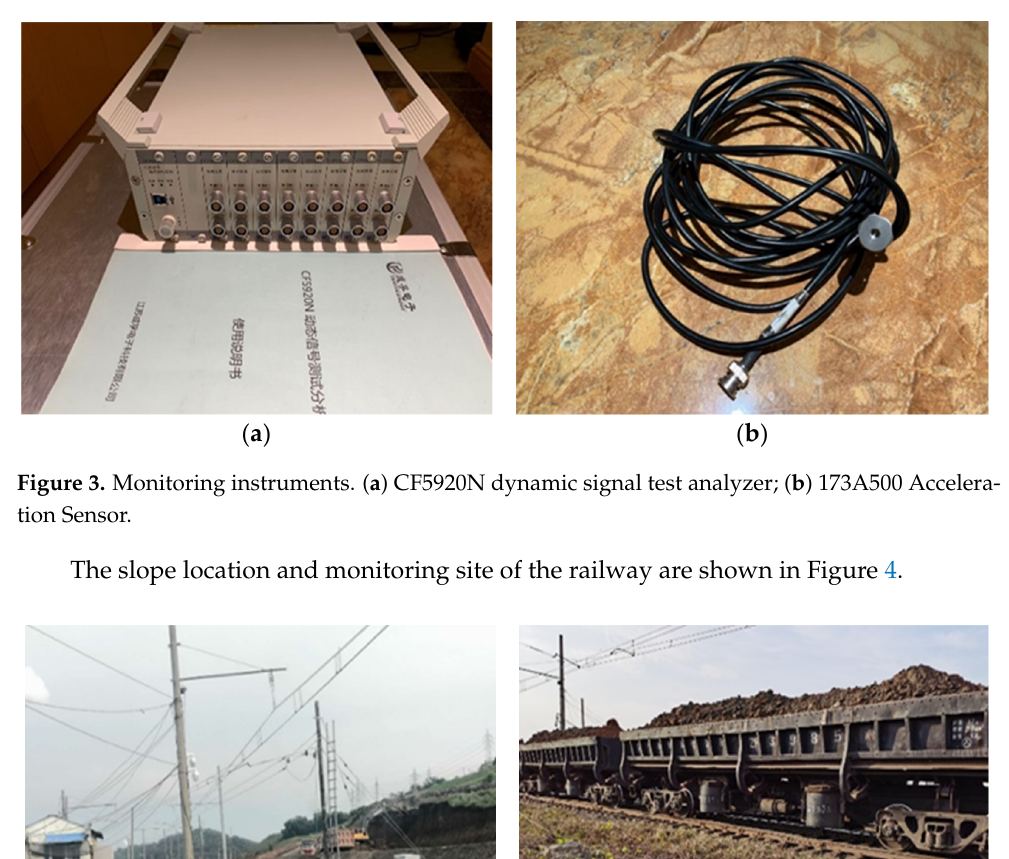
Figure 2. Monitoring location diagram. ( a ) Schematic diagram of the measuring point layout. ( b ) Cross-sectional view of monitoring location.